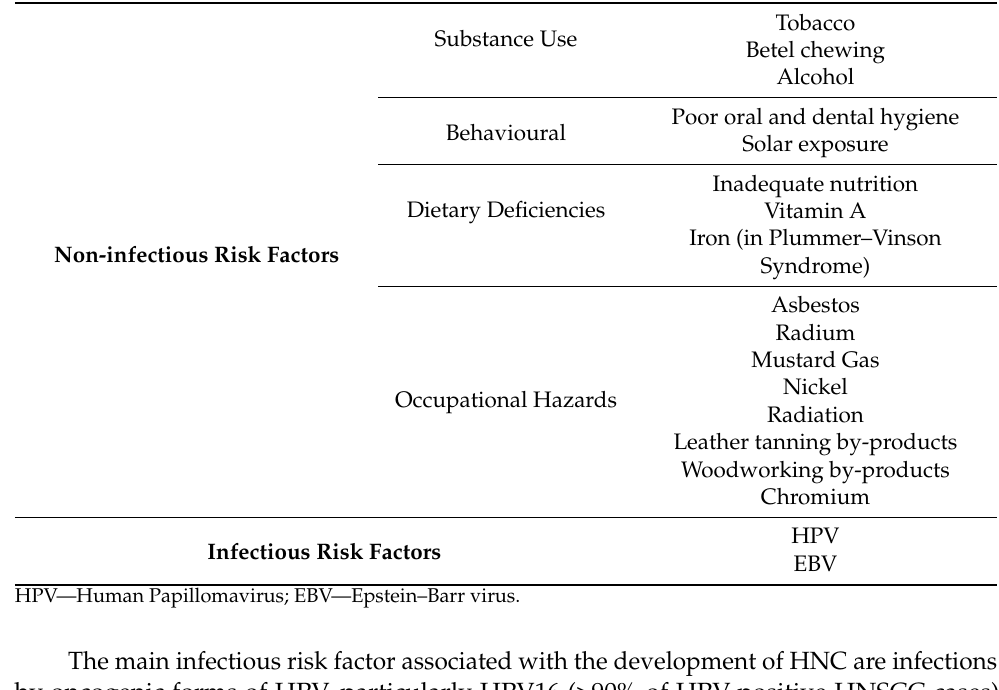
Table 1. Etiologic factors of